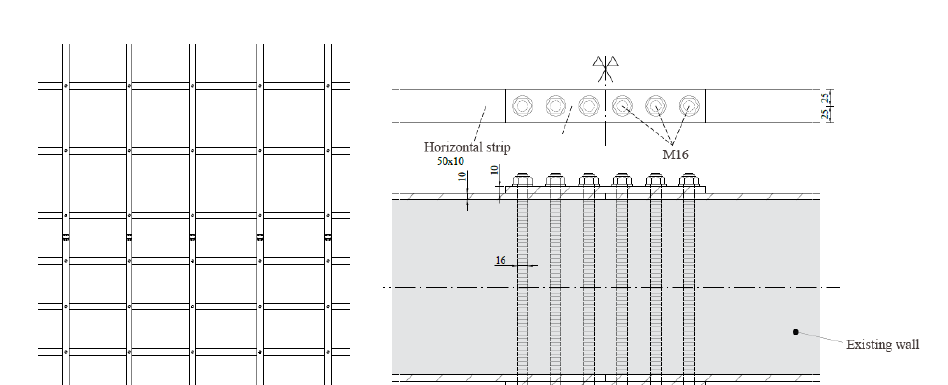
Figure 14. Geometry of RC cores.